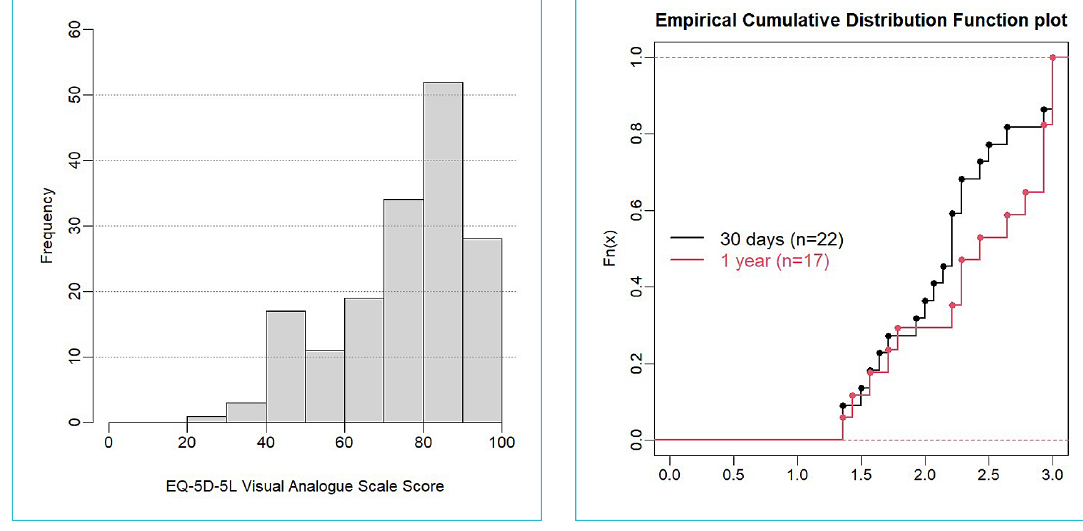
Figure 2: EQ-5D-5L Visual Analogue Scale (VAS) scores one-year after discharge after acute COVID-19 episode. Scores on the EQ-5D-5L VAS in 165 patients at 1-year follow up (patient’s own judgment on quality of life in a scale range from 0 to 100, with higher scores indicating better health status). Bars are right closed and left opened. Median score was 80 (IQR 70–90).